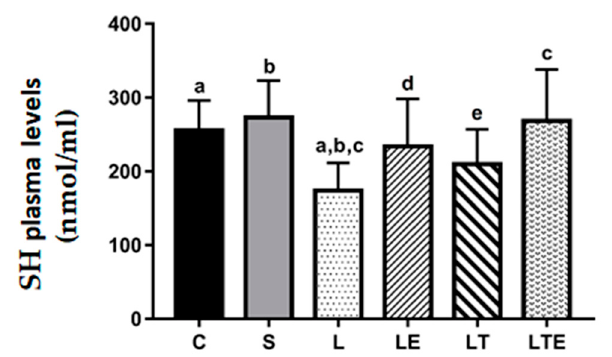
Figure 5. Plasma sulfhydryl (SH) analysis. Plasma sulfhydryl (SH) levels (nmol / mL) after interventions in the di ff erent groups: C, control group; S, sham group; L, injury group; LE, injury + extract group; LT, injury + training group; LTE, injury + training + extract group. Values are expressed as mean ± standard deviation ( n = 10 in each group). The letters “a”, “b”, “c”, “d” and “e” when repeated indicate statistical di ff erences between the groups as determined by one-way ANOVA followed by Bonferroni’s post-hoc correction.